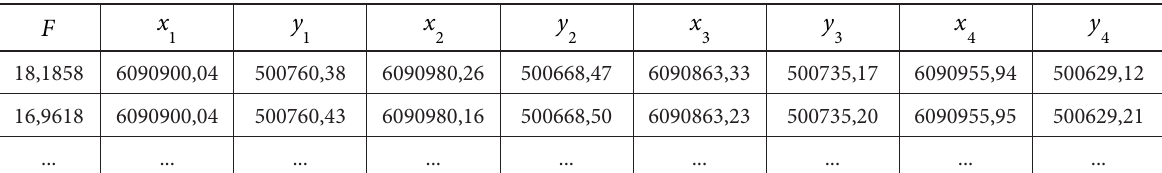
Table 4. Decussate